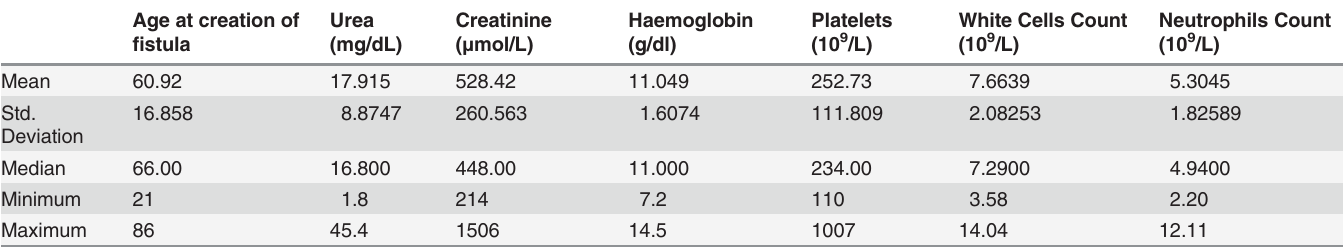
Table 2. Characteristics of continuous variables.